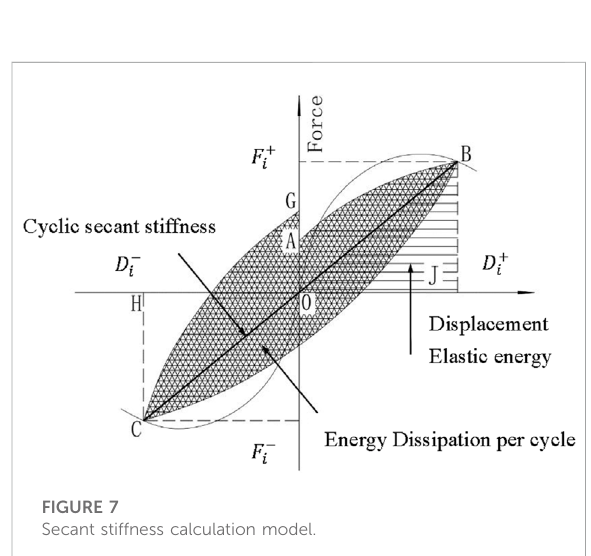
FIGURE 7 Secant stiffness calculation